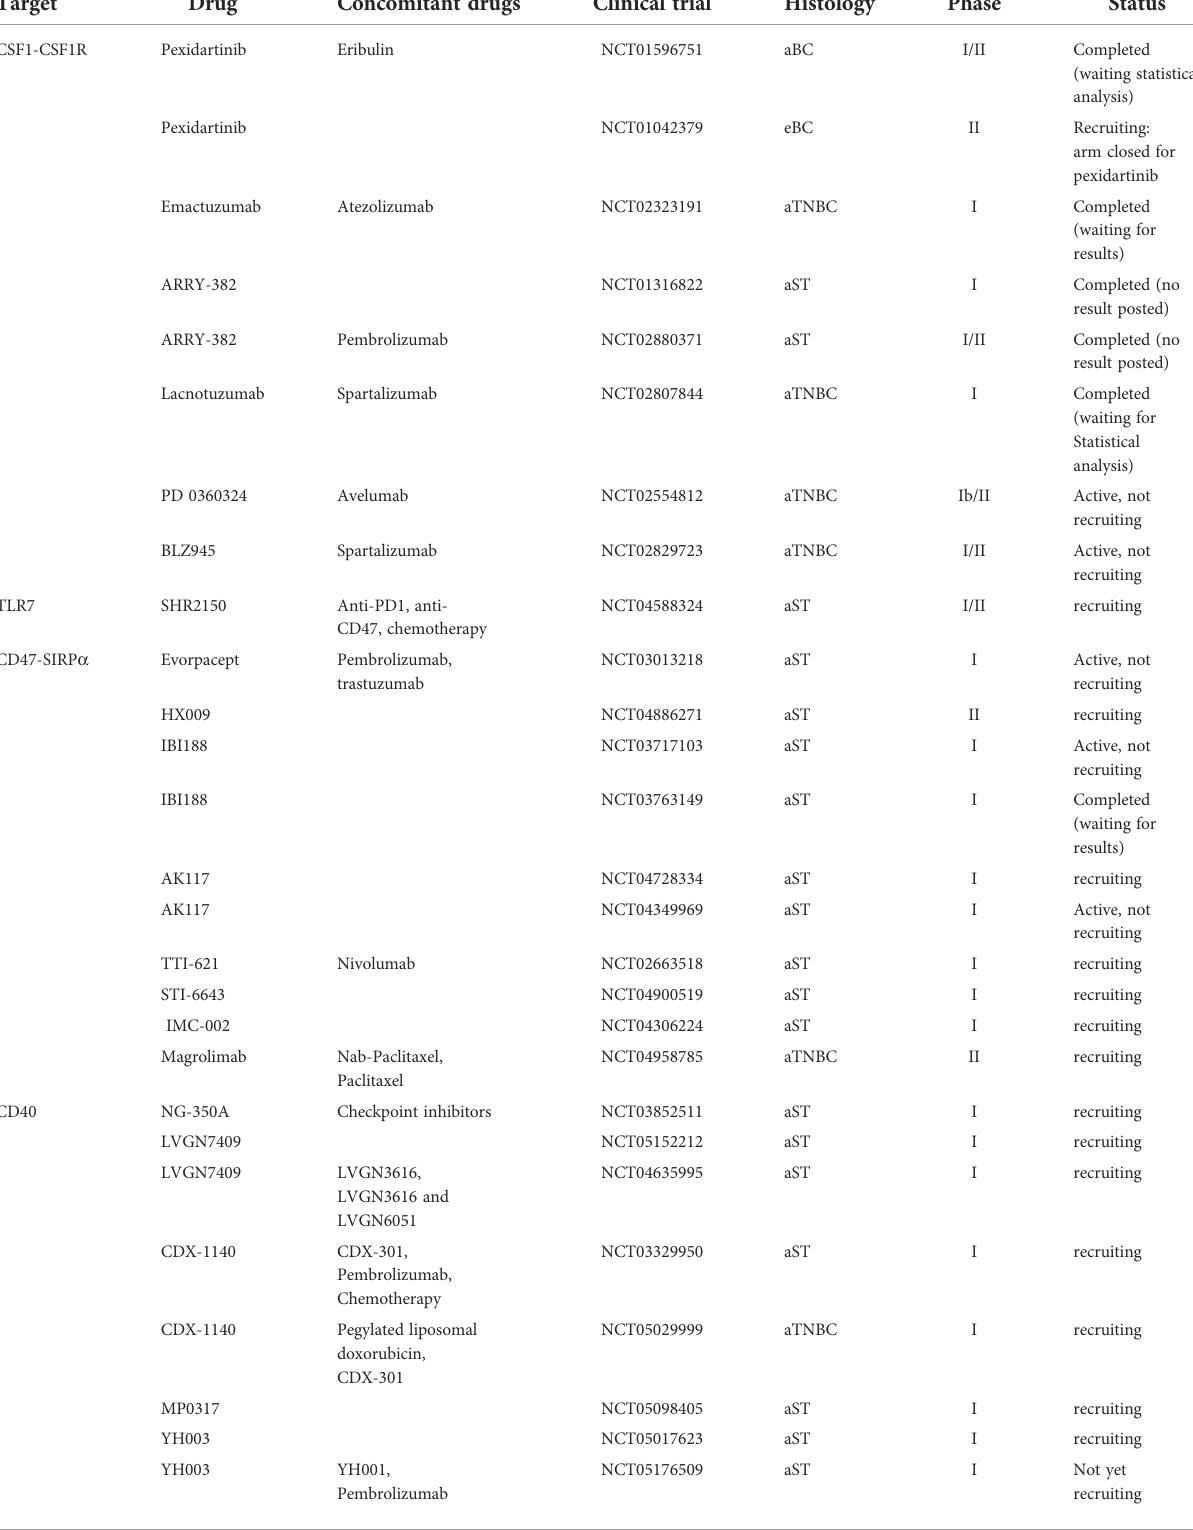
TABLE 4 Clinical trials enrolling breast cancer patients involving new treatments targeting